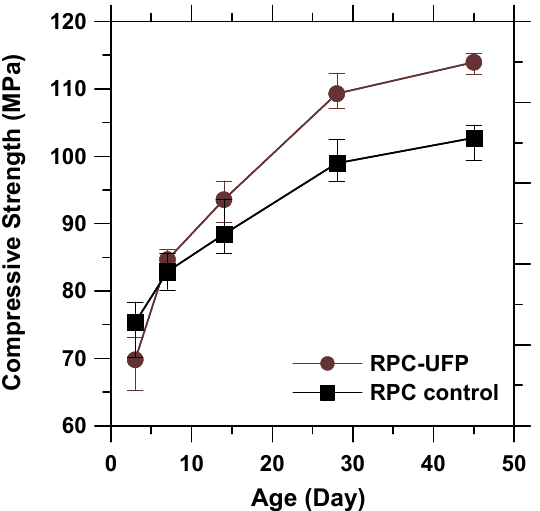
Figure 7. Compressive strength of RPC control and RPC-UFP.